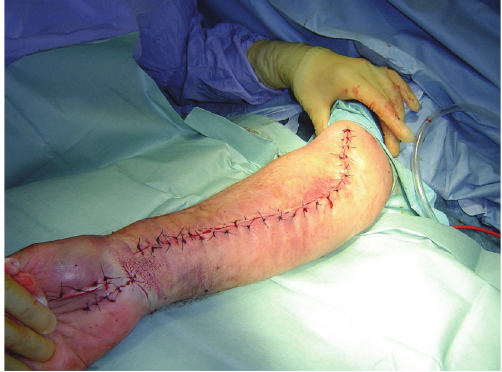
Figure 3: Delayed primary closure of the fasciotomy